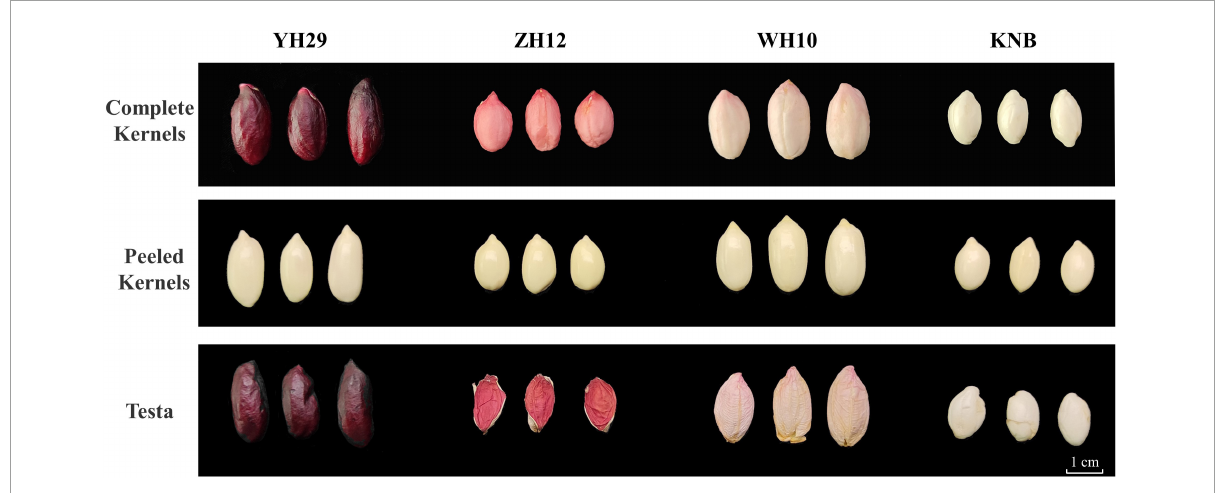
FIGURE1 Phenotypic differences in the four color testa of peanut. Differences of complete kernels, peeled kernels, and testa color phenotypes among four varieties on the period of DAP 70.